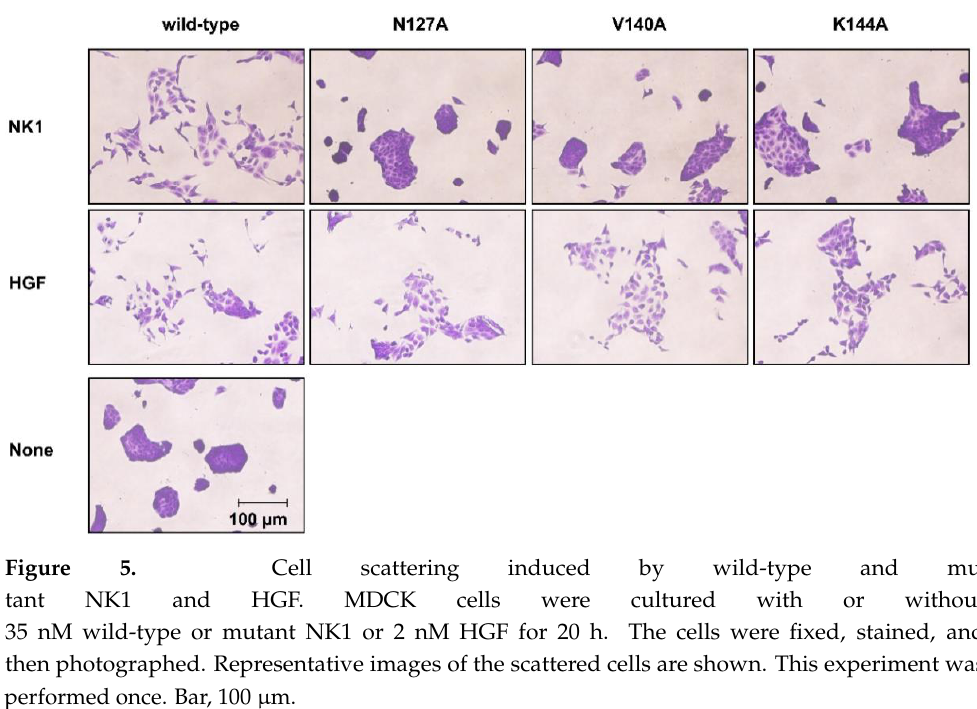
Figure 5. Cell scattering induced by wild-type and mutant NK1 and HGF. MDCK cells were cultured with or without 35 nM wild-type or mutant NK1 or 2 nM HGF for 20 h. The cells were fixed, stained, and then photographed. Representative images of the scattered cells are shown. This experiment was performed once. Bar, 100 m.